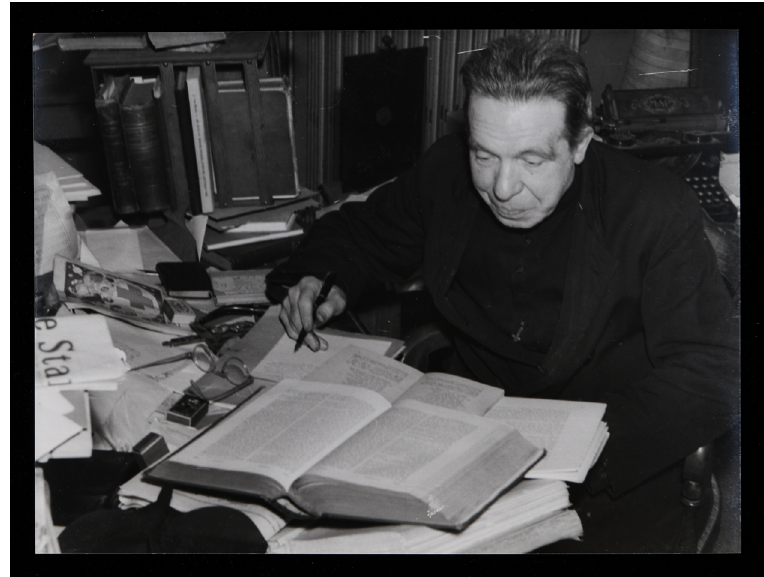
Fig. 3 Jozef van Mierlo, SJ ( De Standaard , Paul Van den Abeele, 1948), Bibliotheek van het Ruusbroecgenootschap,